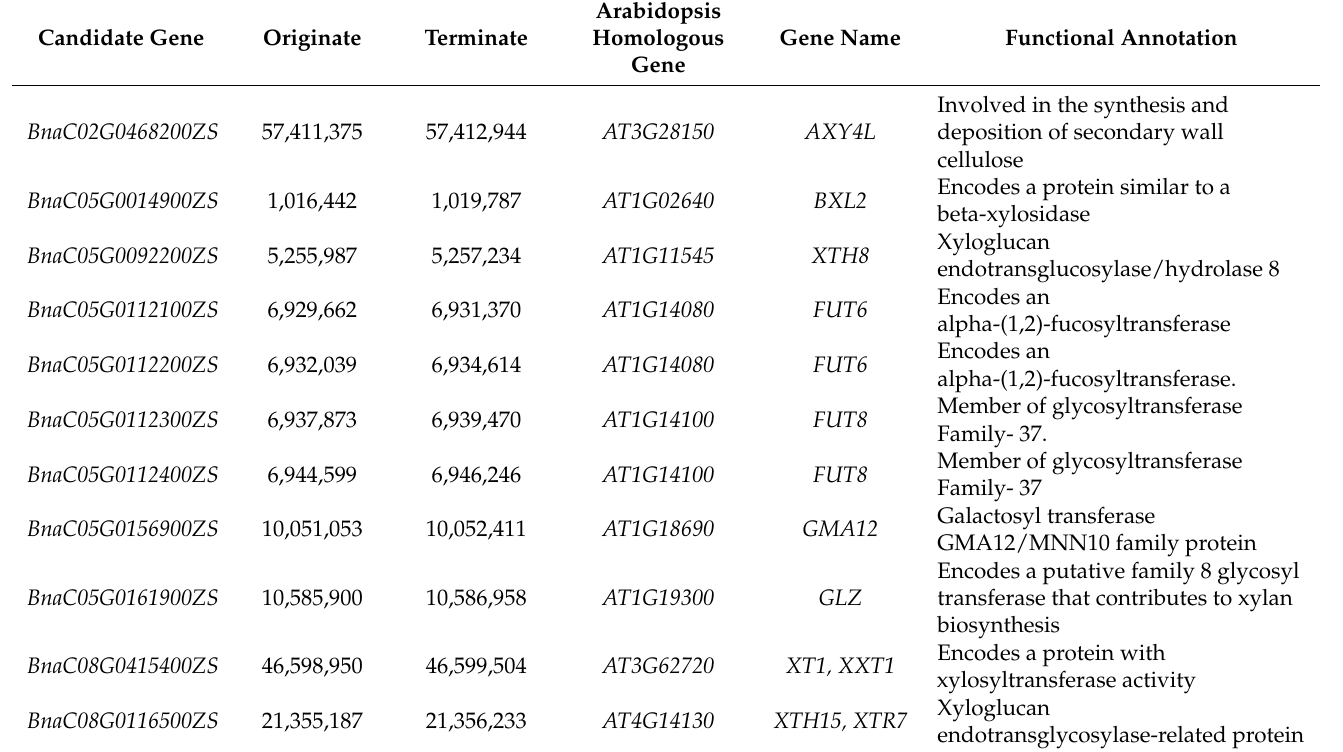
Table 3. Information of candidate genes associated with hemicellulose content in stalk and taproot of Brassica napus